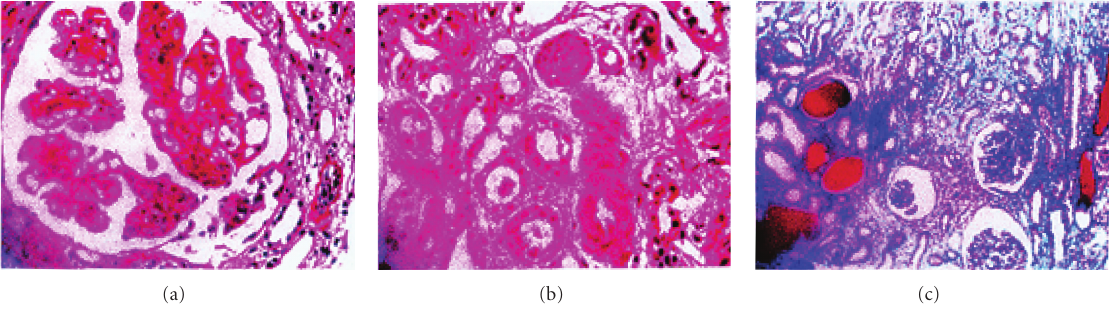
Figure 1: Renal biopsy showing Microangiopathic glomerulonephritis.